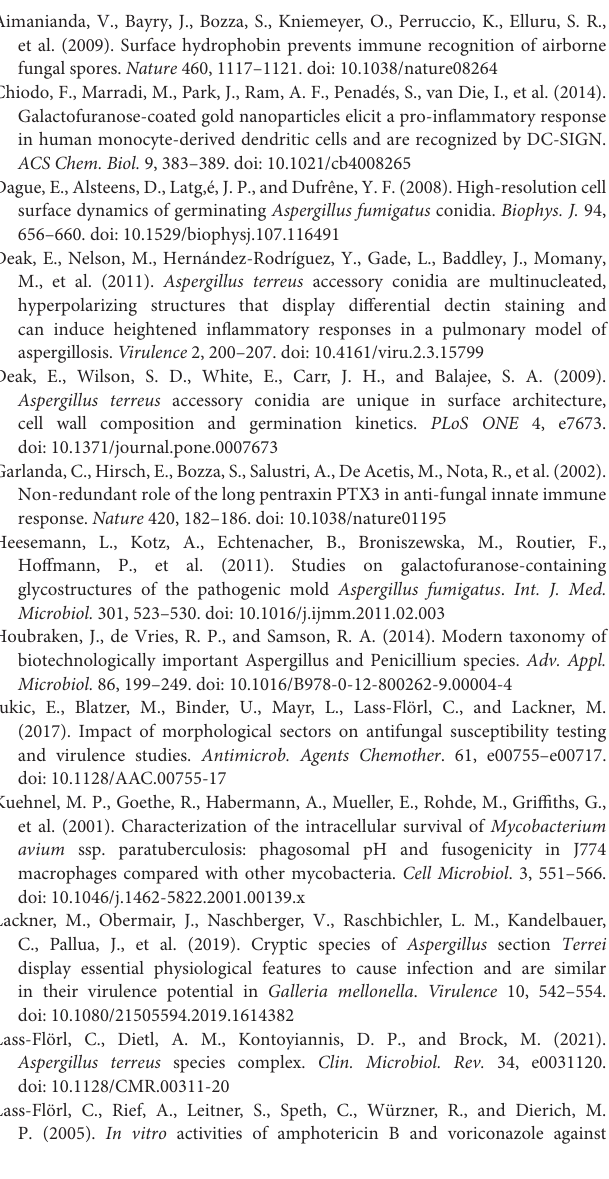
Supplementary Figure 1 | Staining of hyphae of the A. terreus strains T9 and SBUG844 with the galactomannan-specific antibody L10-1 (red) and Calcofluor white (blue). (B,D) are maximum intensity projections; (A,C) show the corresponding (single plane) brightfield images. The positions of selected AC are indicated by arrows. The bar in (C) represents 10 µ m and is valid for all panels. Supplementary Figure 2 | Comparison of the germination of two different types of conidia from A. terreus and PC of A. fumigatus . Germination of purified AC of strain At17-14 and PC of the A. terreus strains At17-14 and SBUG844 as well as